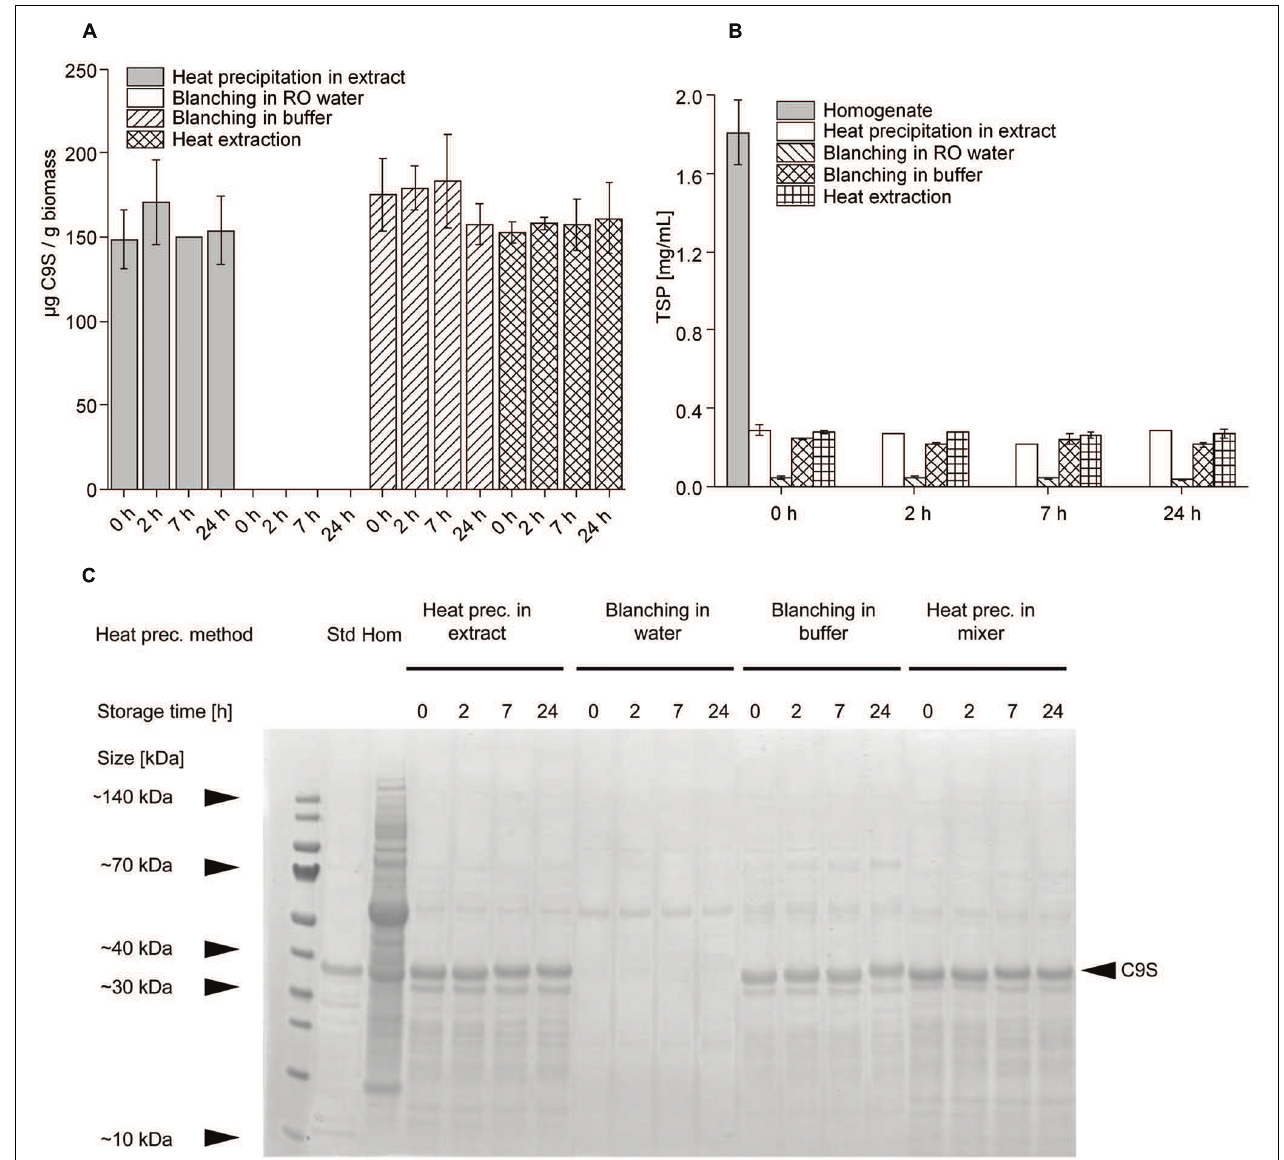
FIGURE 6 | Comparison of the influence of different heat precipitation methods (heat precipitation, blanching in water, blanching in buffer, heat extraction) at 80 ◦ C on target protein concentrations (A,C) and TSP levels (B). Target protein stability was achieved by heat precipitation in extract, blanching in buffer and heat extraction. The band representing target protein C9S in the Coomassie-stained gel shown in panel (C) is indicated with a black